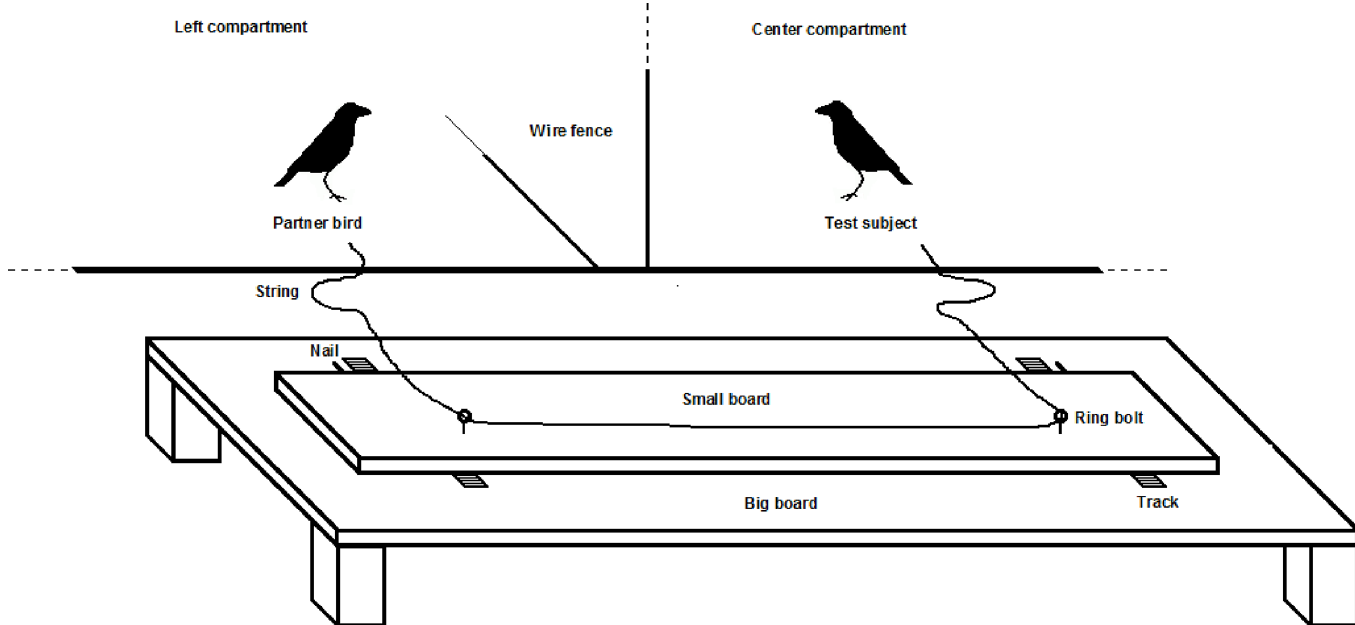
Fig 1. Sketch of a loose string paradigm apparatus. The small board could move along the tracks if the strings were simultaneously pulled. If only one subject pulled or if both subjects pulled asynchronously, the string was pulled through the ringbolts without affecting the small